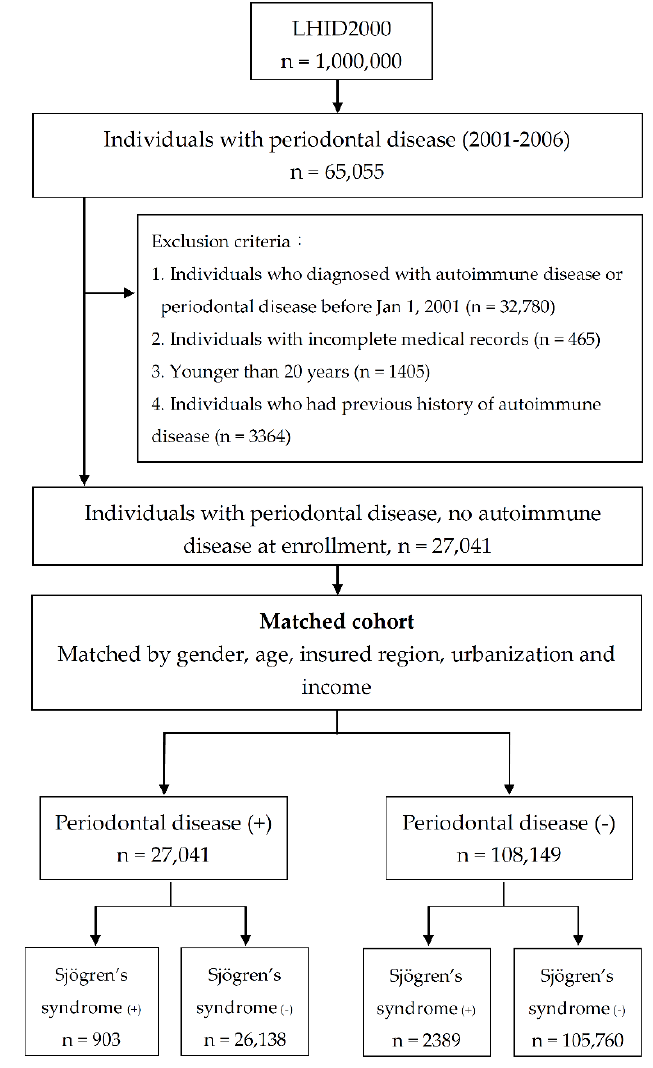
Figure 1. Flow chart illustrating the enrollment of study